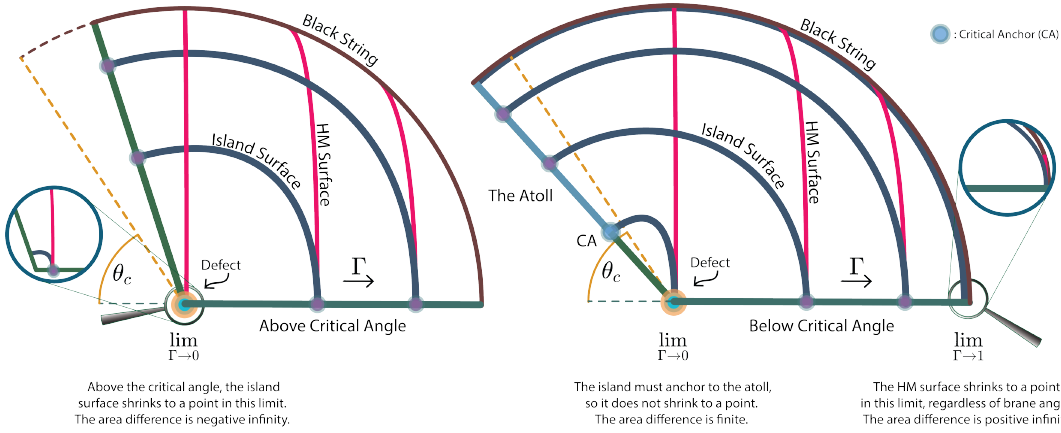
Figure 8 . This cartoon illustrates how the area difference is affected by each limiting case for the boundary anchor point Γ , with angles below the critical angle on the right, and angles above the critical angle on the left. Taking the difference between the surfaces essentially acts as a renormalization scheme. The area difference between the island surface and HM surface diverges when one of them shrinks to a point because the difference between the surfaces reaches farther into the boundary region. When the brane lies below the critical angle, the island surface cannot shrink to a point when Γ → 0 because it anchors to the brane inside the